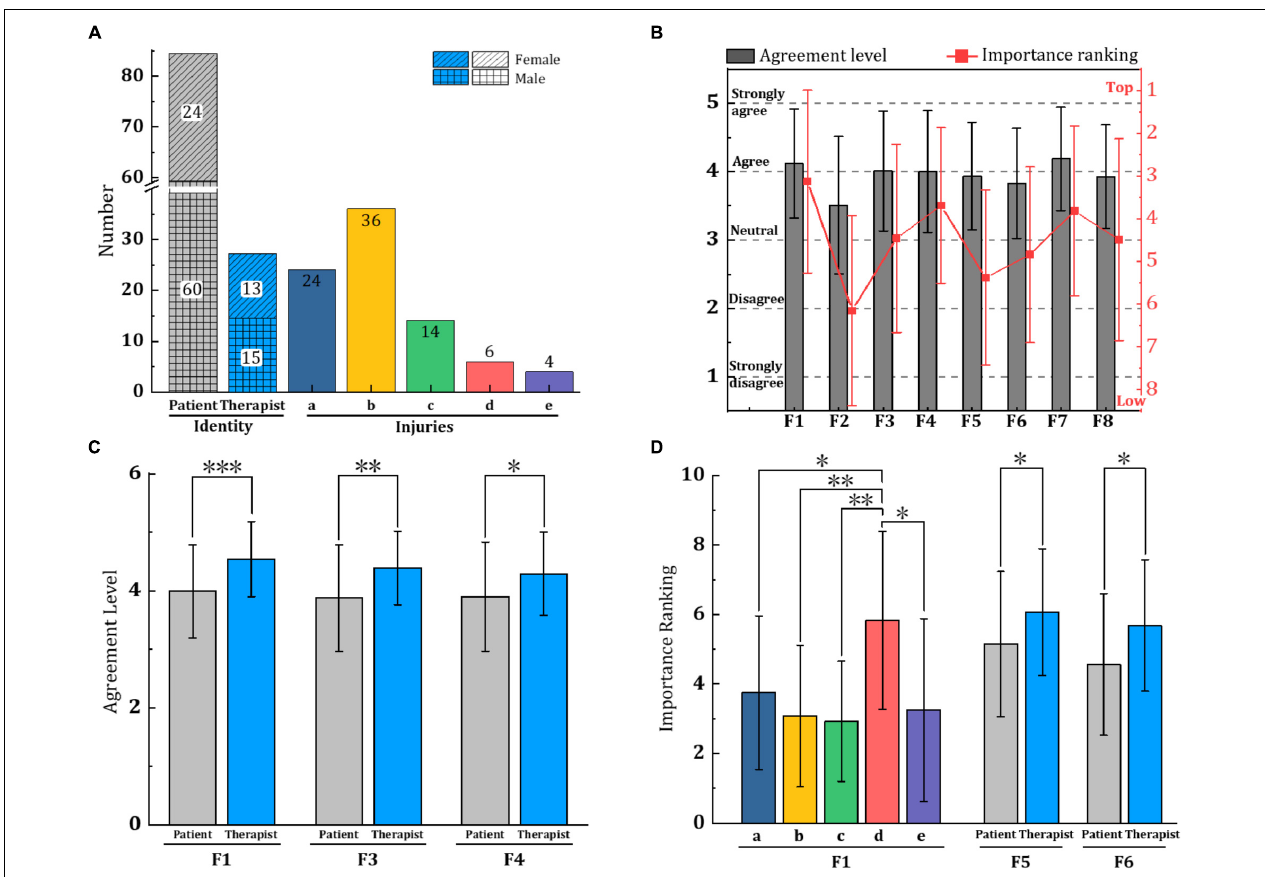
FIGURE 2 | Statistical results from 28 therapists (age 25.4 ± 2.67 years old, height 167.4 ± 5.85 cm, weight 62.8 ± 13.3 kg) and 84 patients (age 42.1 ± 13.7 years old, height 166.02 ± 18.47 cm, weight 70.1 ± 21.6 kg), with ethics approval from Shanghai Sunshine Rehabilitation Center (2018083101). All participants have over-5-hours experience in robot-assisted therapy. In the charts, “a” to “e” denotes five types of injuries: a-musculoskeletal injury, b-stroke, c-spinal cord injury, d-brain trauma, and e-others (such as anthracaemia and brain tumor) in corresponding colors. (A) Describes the proportions of involved subjects and injuries; (B) illustrates mean values of the agreement level and importance ranking of eight factors from all 112 participants; (C,D) illustrate the ANOVA analysis results of identity and injuries over different factors. Asterisk denotes the significant difference between two elements, especially, ∗∗∗ P -value < 0.001, ∗∗ P -value < 0.01, and ∗ P -value <